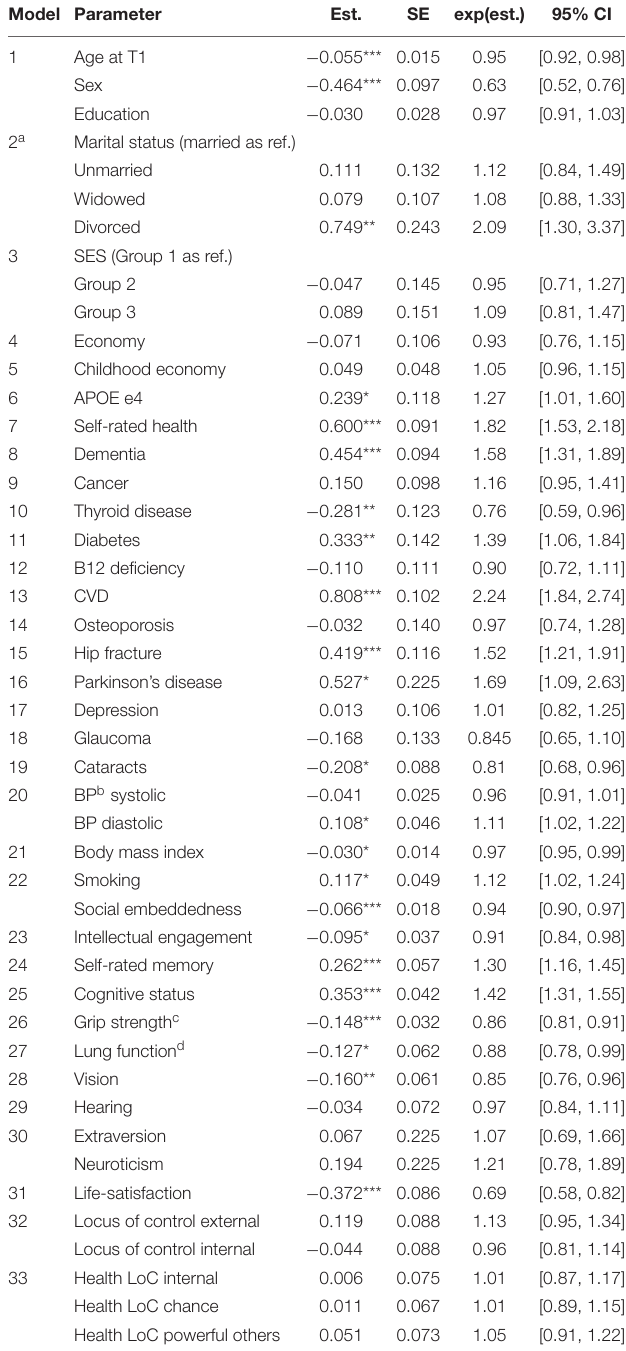
TABLE 3 | Parameter estimates from Cox proportional hazard models with age of death as outcome. Model Parameter Est. SE